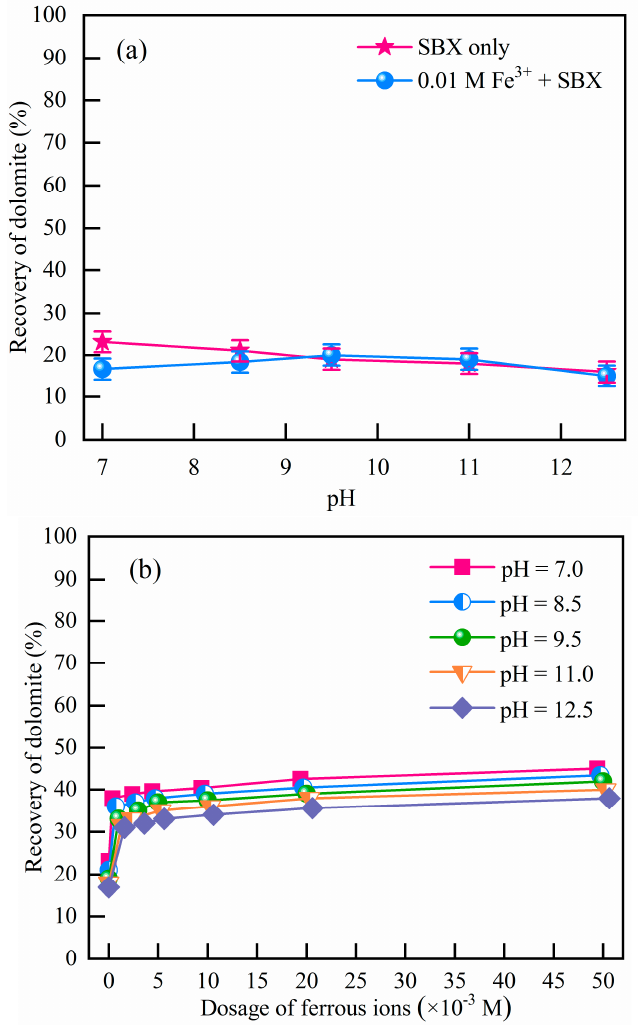
Figure 1. Floatability of dolomite with the addition of Fe 3+ ( a ), and Fe 2+ ( b ) (c(SBX) = 10 − 3 M).